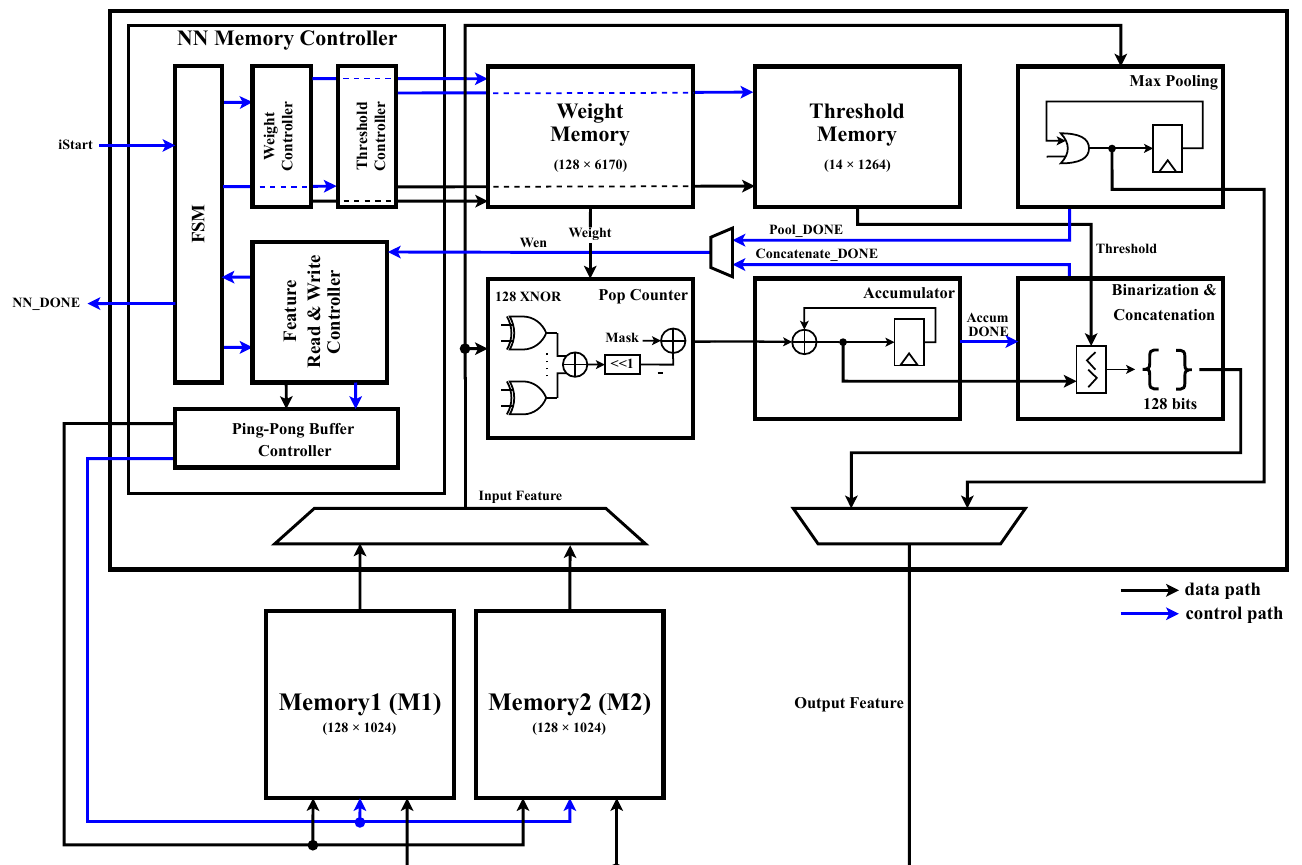
Figure 9. Block diagram of the BNN unit.